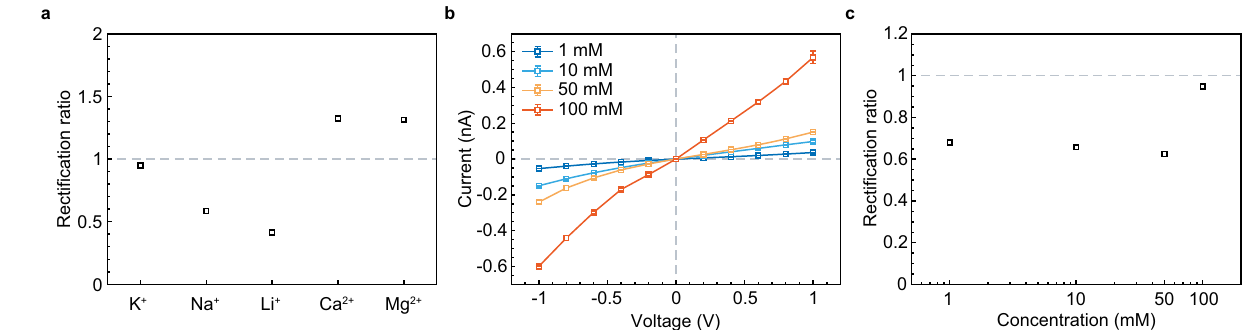
Fig. 3 | Recti fi cation of graphene-based polyethylene terephthalate nano- channel(GPETNC).a Recti fi cationratiooftheGPETNCindifferentcation-chloride solutionswithconcentrationsof0.1M. b I – V curvesoftheGPETNCinKClsolutions